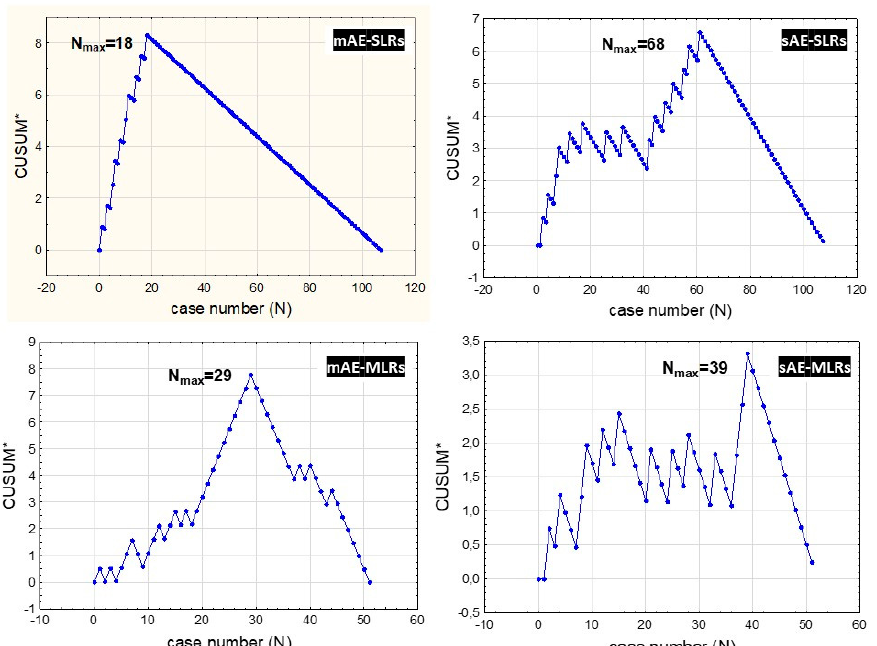
Figure 2. Cumulative sum control chart of operative (CUSUM *) minor adverse effects (MAEs) and severe adverse effects (SAEs) against the number of patients with small liver resections (SMLs) and CUSUM MAEs and SAEs against the number of patients with major liver resections (MLRs); N = 107.